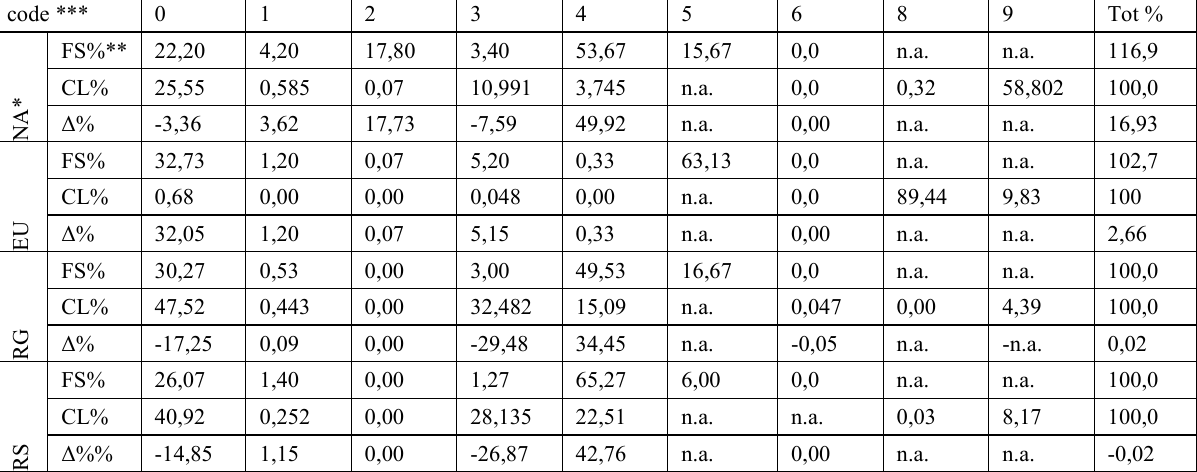
Table 10. Land cover percentages of Block 1 identified in Alexander Stream National Park and discrepancies between the two methods implemented. *Natural (NA), Eucalyptus (EU), Regeneration (RG), Restoration (RS). **Field Sampling (FS), Classification results (CL), Discrepances (Δ%). ***Coding: Herbaceous plants (0), Woody plants (1), Dry woody materials (2), Bare soil